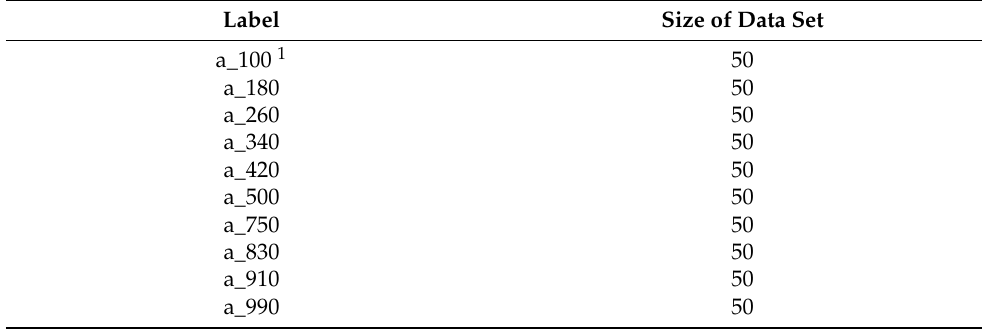
Table 1. Expanded data set labeled with 10 classes based on the defect locations.